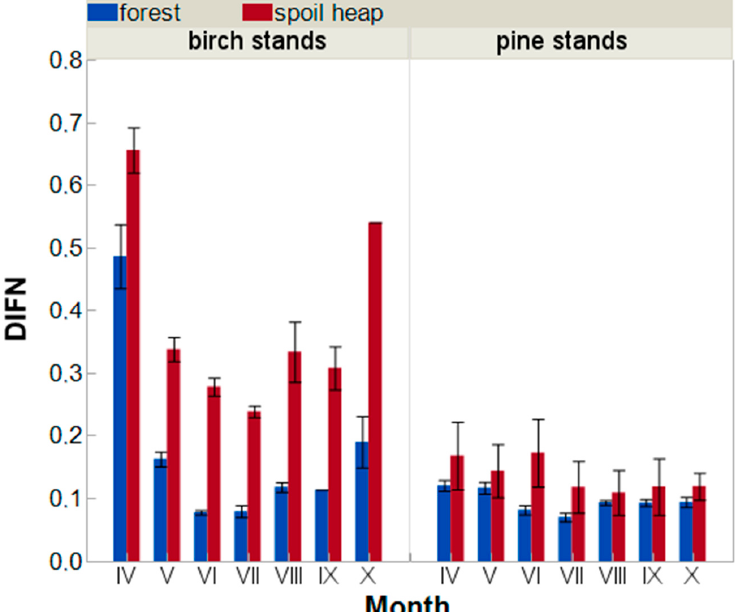
Figure A2. The average canopy openness index (diffuse non-interceptance; DIFN) measured during the 2015 growing season (±SE) in birch and pine stands growing in two different site types—post-mining external spoil heap (red) or forest sites (blue).